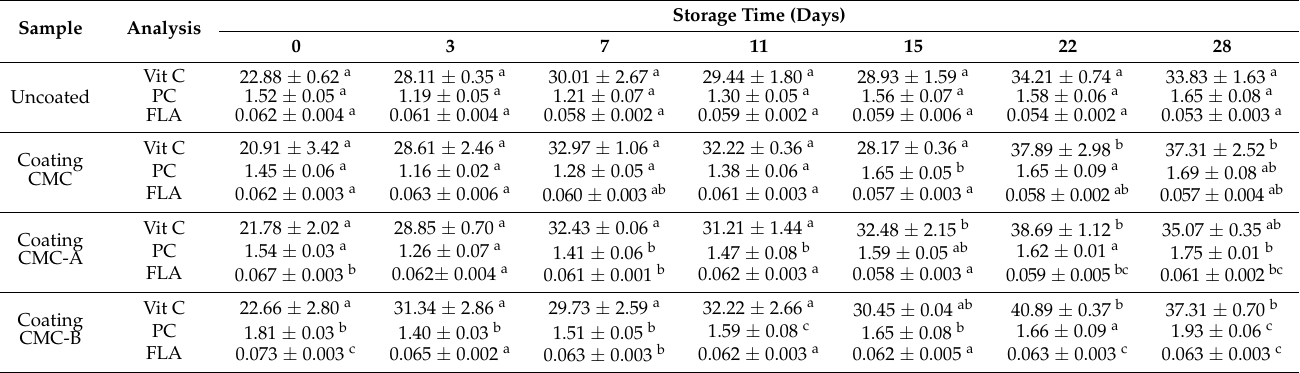
reported as milligrams of gallic acid equivalent per grams of fruit (mg GAE/g fruit) and milligram of quercetin equivalent per grams of fruit (mg QE/g fruit), respectively. Different letters within each analysis in the same storage day correspond to statistically different samples for a 95% confidence level. Table 4. Vitamin C (Vit C), total phenolic compounds (PC), and flavonoids (FLA) values of the coated and uncoated fresh goldenberries stored at 4 ◦ C and 95% RH for 28